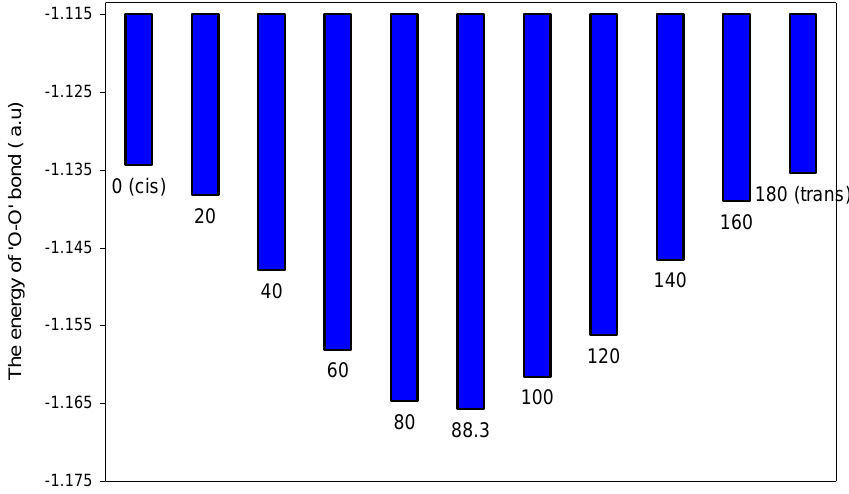
Figure 3. Plot of 'O-O' bond energy as a function of torsional angle in Hydrogen